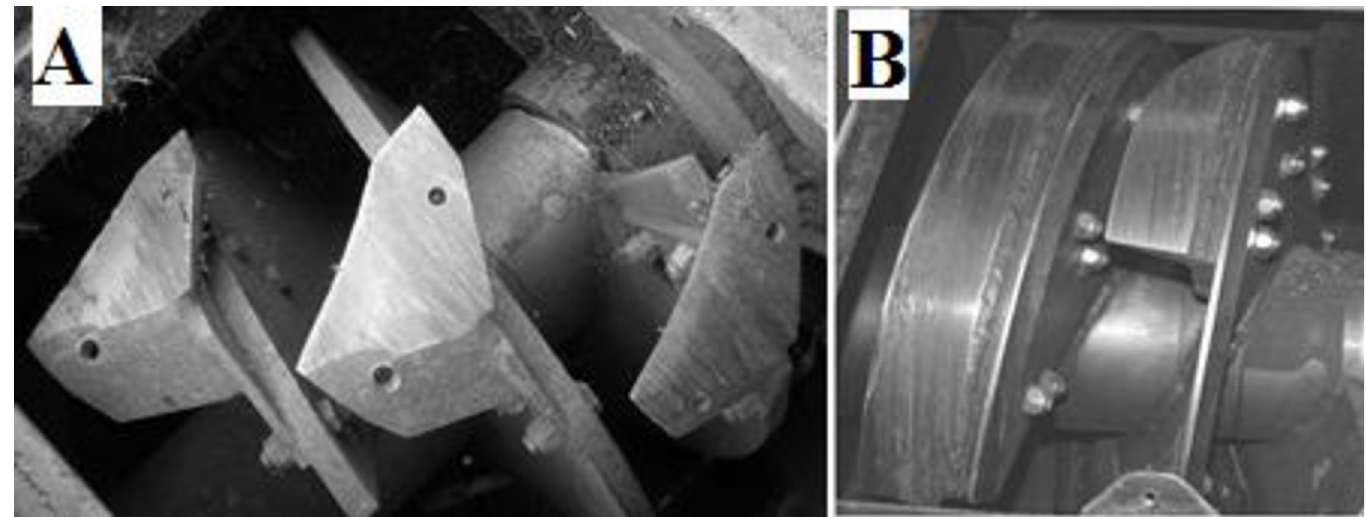
Fig 2. Types of knife of Naldoni prototype that used during the trial in the field. A) discontinuous hoe shaped knife (d_HSK); and B) continuous helicoidal knife (c_HEL).